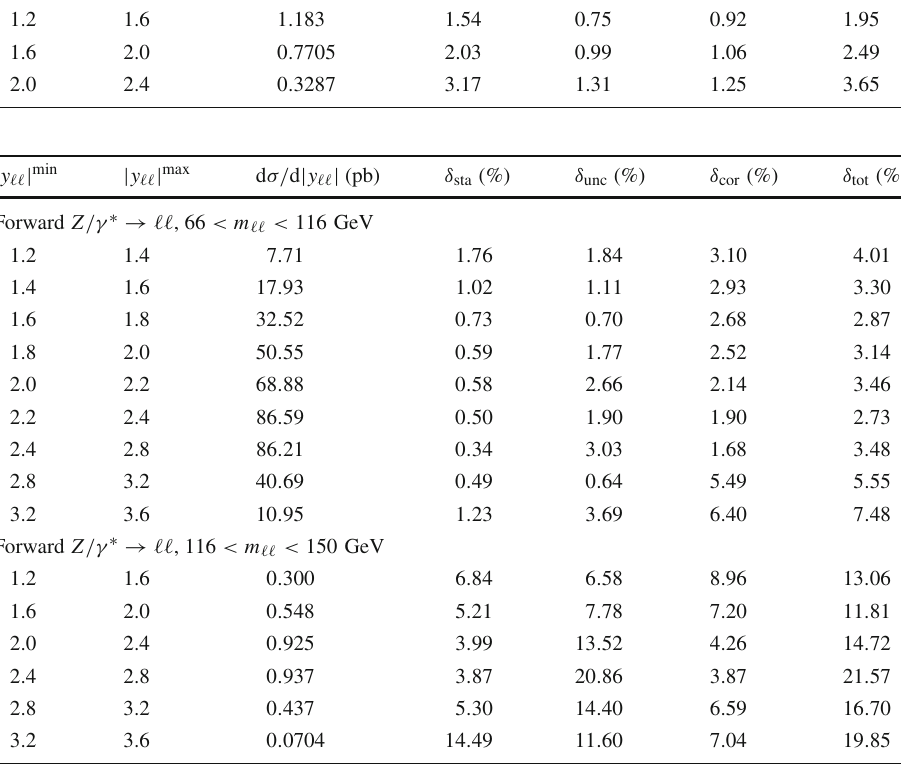
section for the Z /γ ∗ → (cid:3)(cid:3) process in the forward region in two dilepton invariant mass ranges, extrapolated to the common fiducial region. The relative statistical ( δ sta ), uncorrelated systematic ( δ unc ), correlated systematic ( δ cor ), and total ( δ tot ) uncertainties are given in percent of the cross-section values. The overall 1 . 8% luminosity uncertainty is not